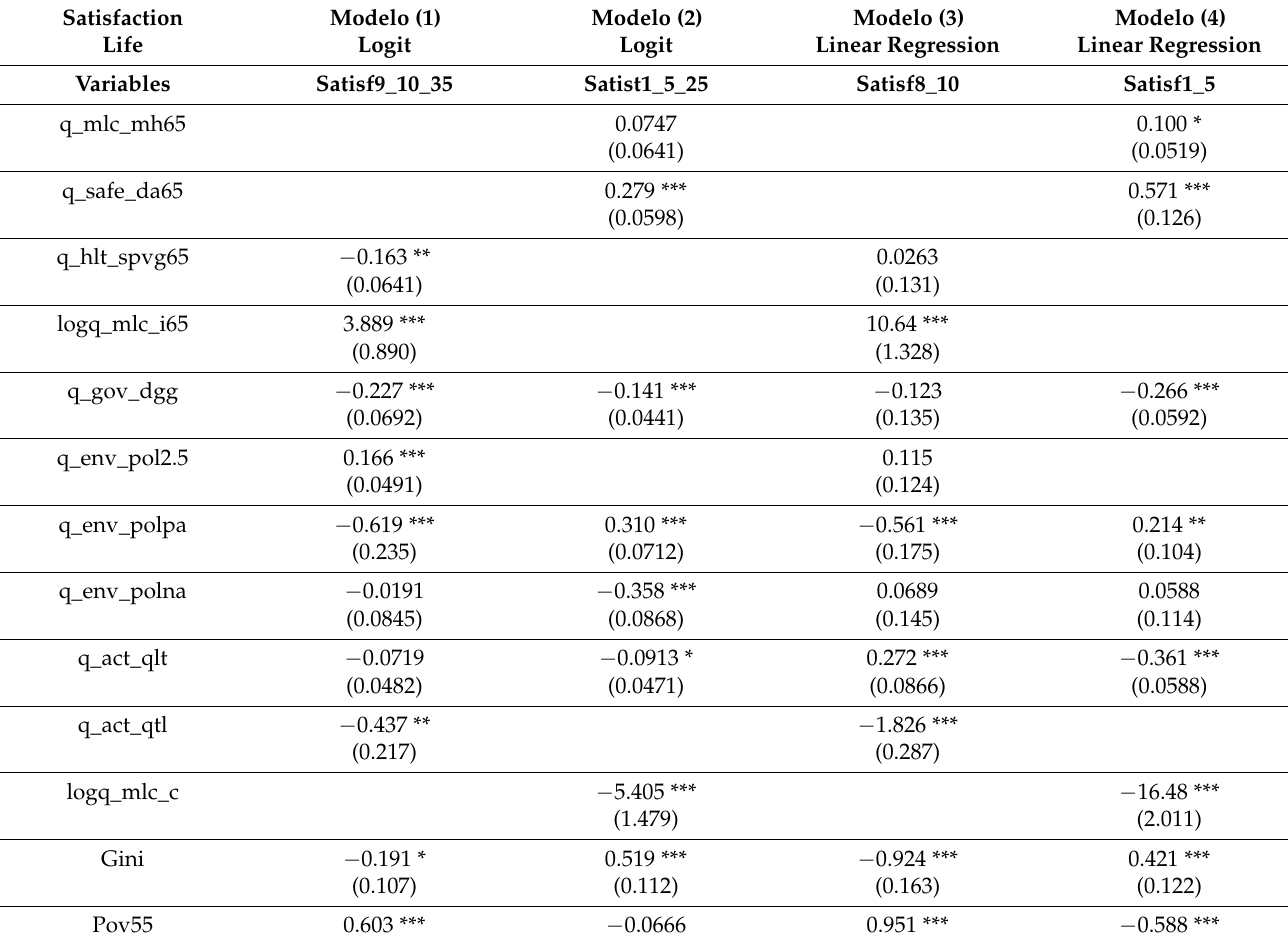
Table 1. Logit and Linear Regression